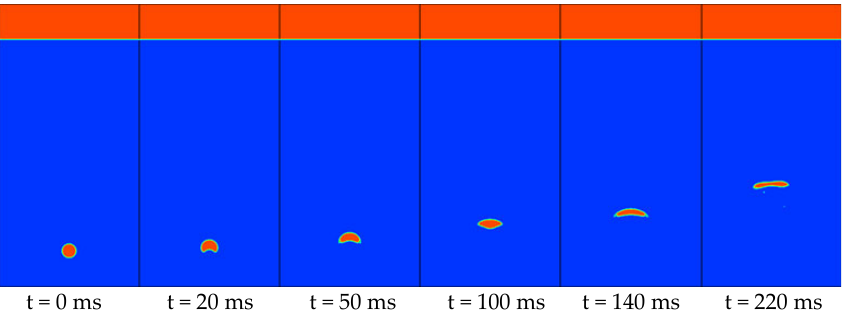
Figure 6. The rising and deformation process of a single central circular bubble without boundary.